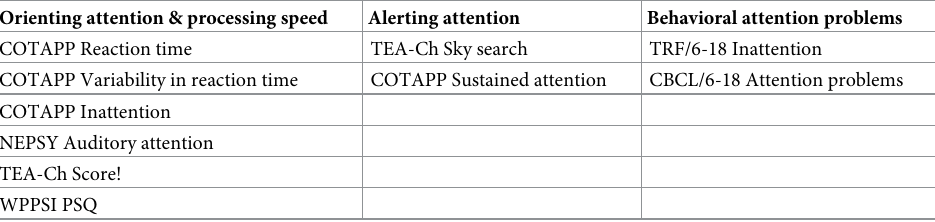
Table 3. Attention domains and corresponding